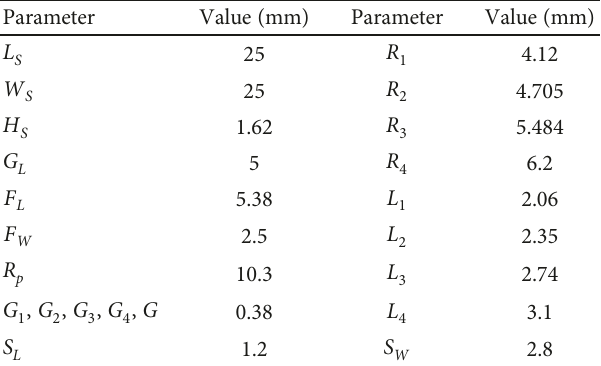
Table 1: Optimal dimensions of the proposed